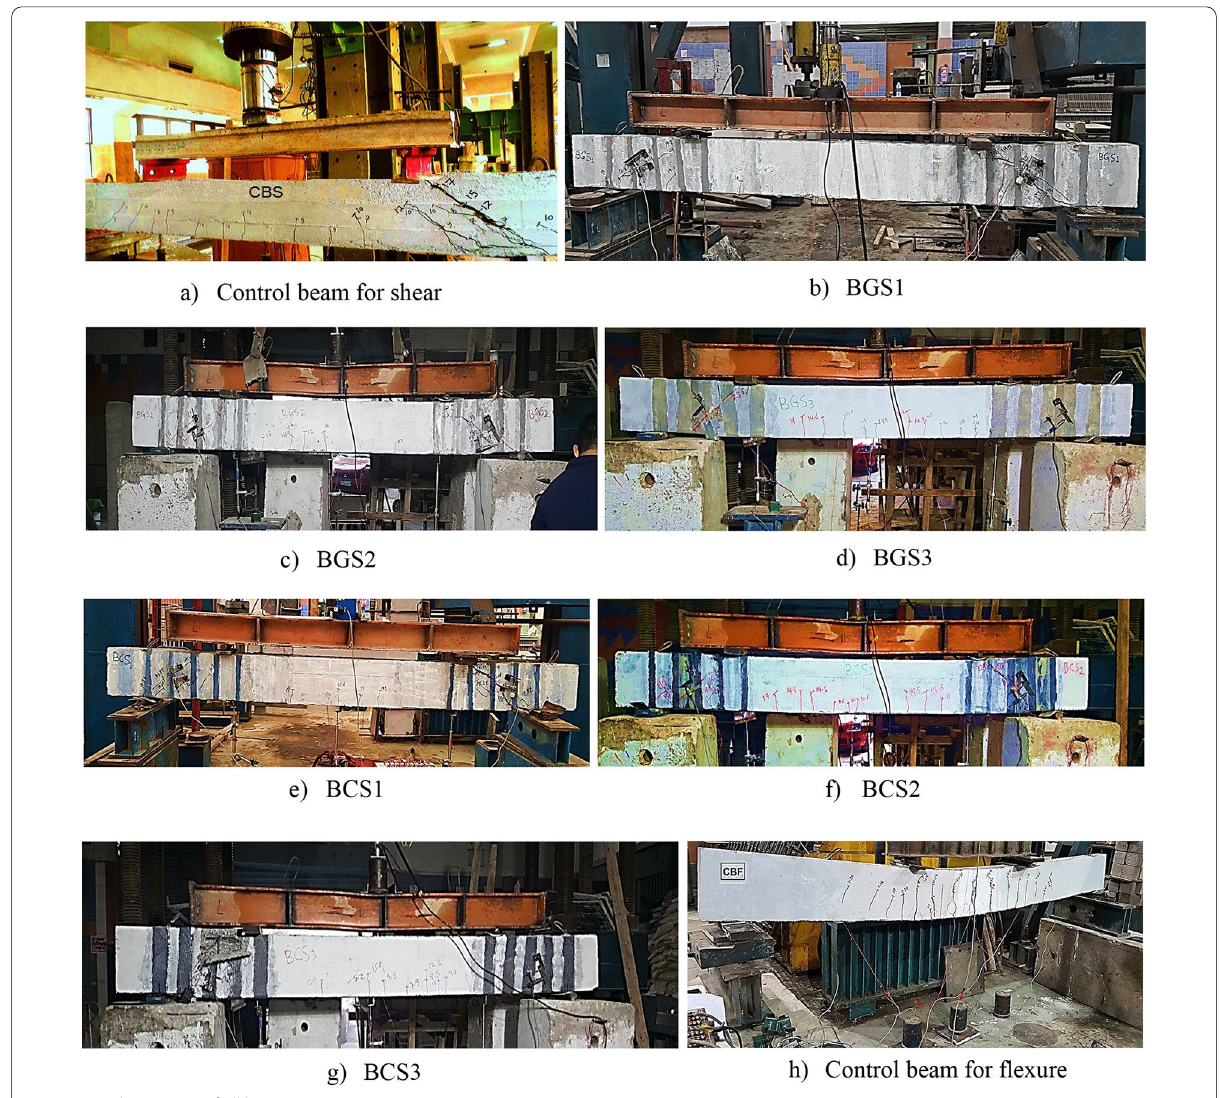
Fig. 9 Crack patterns of all beam